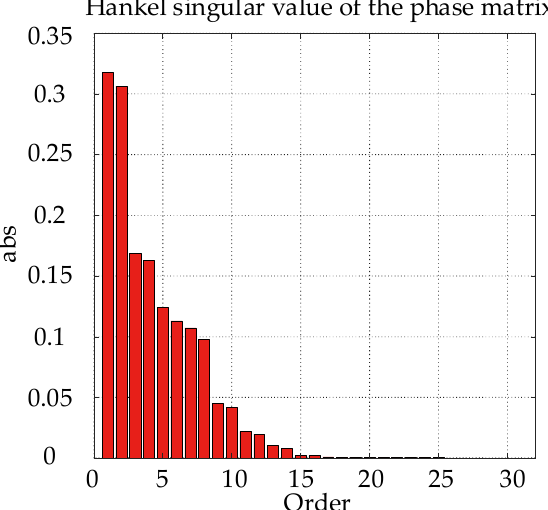
Figure 8. Hankel singular values of the controller.